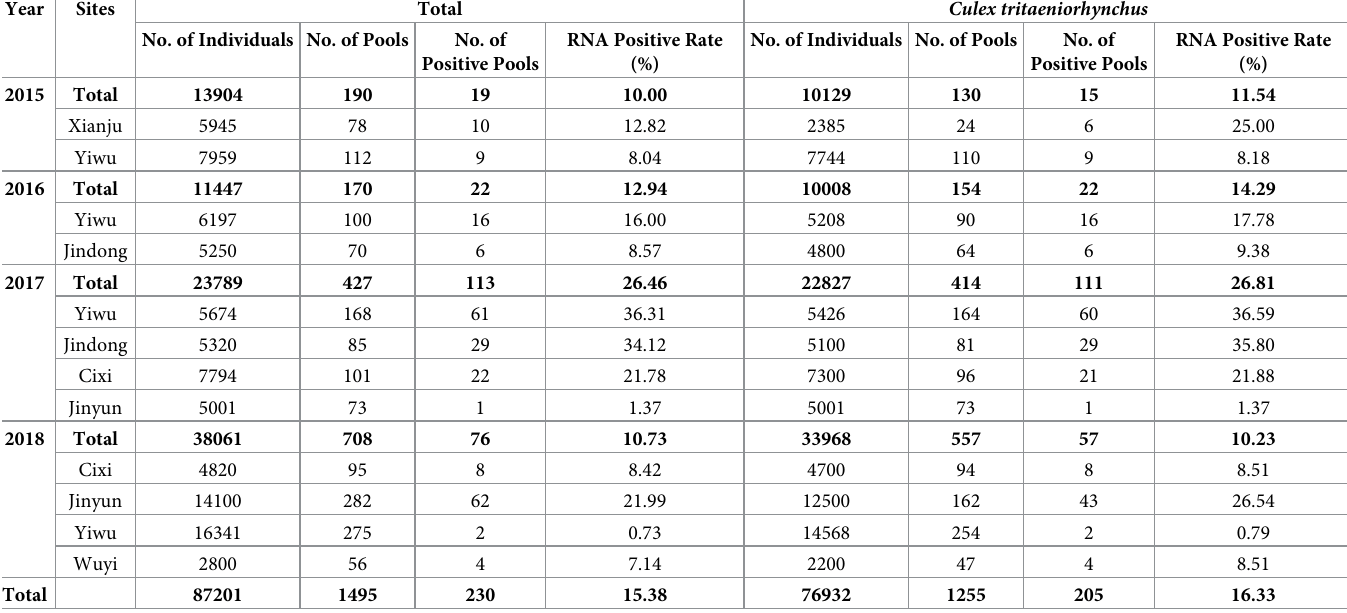
Table 4. Sampling and detection of JE mosquito surveillance in Zhejiang from 2015–2018.